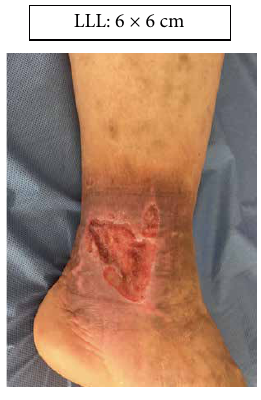
Figure 20: Start. Lower left limb.